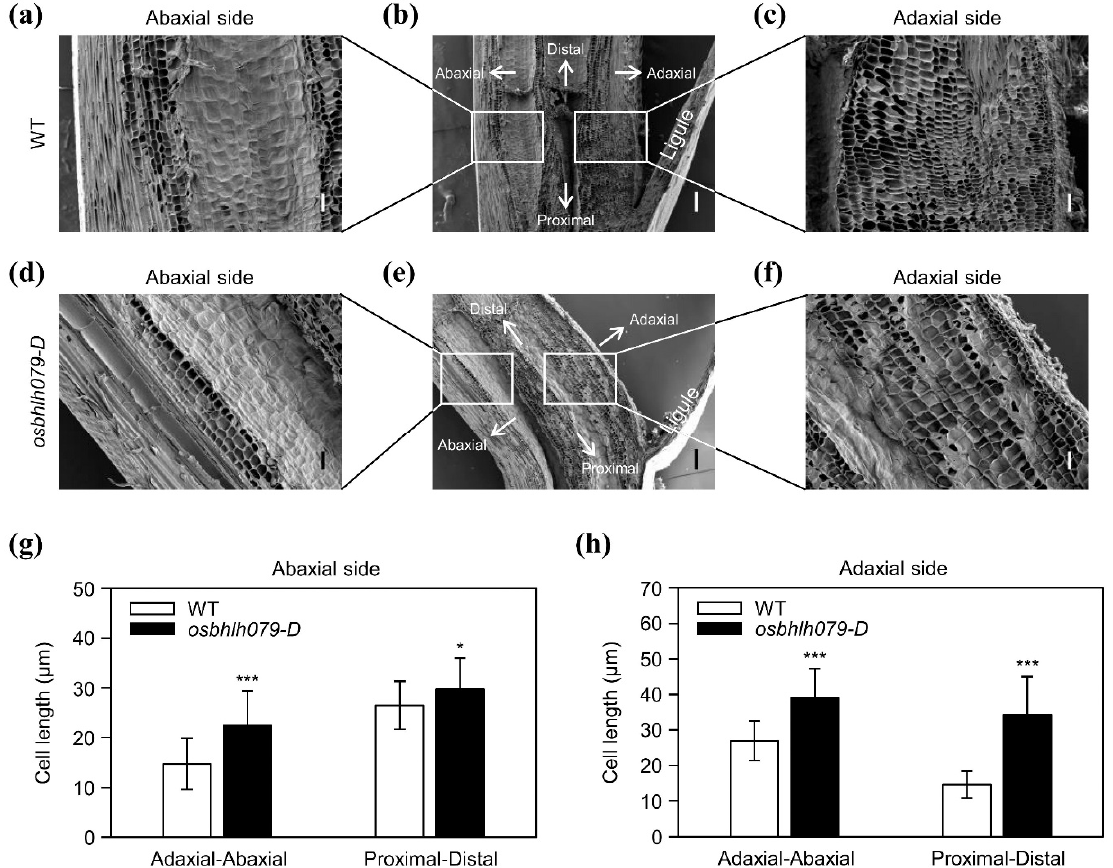
Figure 6. Scanning electron microscopy of the lamina joints of leaves in WT and osbhlh079-D . ( A – F ) Longitudinal sections of the lamina joint of flag leaf in WT ( A – C ) or osbhlh079-D ( D – F ) at heading stage grown under NLD conditions in the paddy field. (A and D) Close-up of abaxial regions denoted by rectangles (left side) in (B and E), respectively. (C and F) Close-up of adaxial regions denoted by rectangles (right side) in (B and E), respectively. Scale bar = 200 μ m in (B and E). Scale bar = 50 μ m in (A, C, D, and F). (G) Statistical analysis of cell lengths in (A and D). (H) Statistical analysis of cell lengths in (C and F). (G and H) Cell lengths along the adaxial–abaxial axis and proximal–distal axis were measured on the abaxial and adaxial sides of lamina joints. Means and standard deviations were obtained from thirty cells. Significant differences between means were analyzed using Student’s t -test (* p < 0.05, *** p < 0.001). These experiments were repeated twice with similar results.